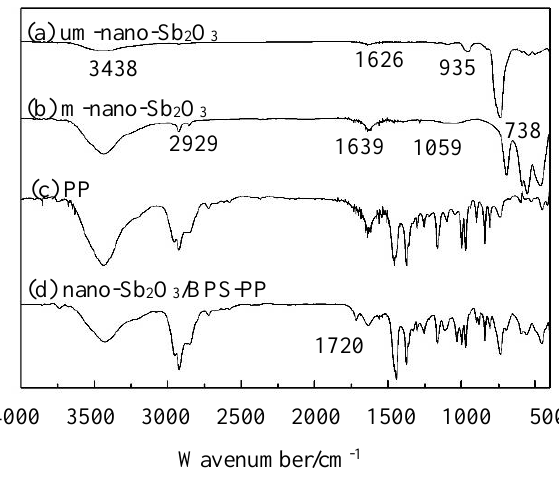
fied nano-Sb O particles contains hydroxyl because the 2 3 nanoparticles easily absorbed moisture in the air at- tributed to the smaller particle size, higher specific surface area and surface energy of the nanoparticles. The curve (b) is the FT-IR spectrum of m-nano-Sb O particles mod- 2 3 ified by KH550. The intensity of stretching vibration char- acteristic peak of hydroxyl at 3438cm −1 increases and the bending vibration characteristic peak of hydroxyl at 1626 cm −1 disappears.Atthesametime,somenewpeaksareob- servedinthecurve(b).Thepeakat1639cm −1 isassignedto N-H bending vibration peak. The peak at 1059 cm −1 is due to the stretching mode of C-O-C, and the peaks near 2929 Figure 2: TEM micrographs of nano-Sb 2 O 3 particles (a) um-nano- cm −1 are associated with -CH and -CH - vibrations. These 3 2 Sb 2 O 3 particles; (b) m-nano-Sb 2 O 3 new peaks belong to the typical characteristics of KH550, indicating that Sb O nanoparticles are successfully mod- 2 3 ified by KH550. When the surface of nano-Sb O adsorbs 2 3 KH550, the hydroxyl groups on the surface of nano-Sb O 2 3 can condense with R-Si-OH of the hydrolysate of KH550.